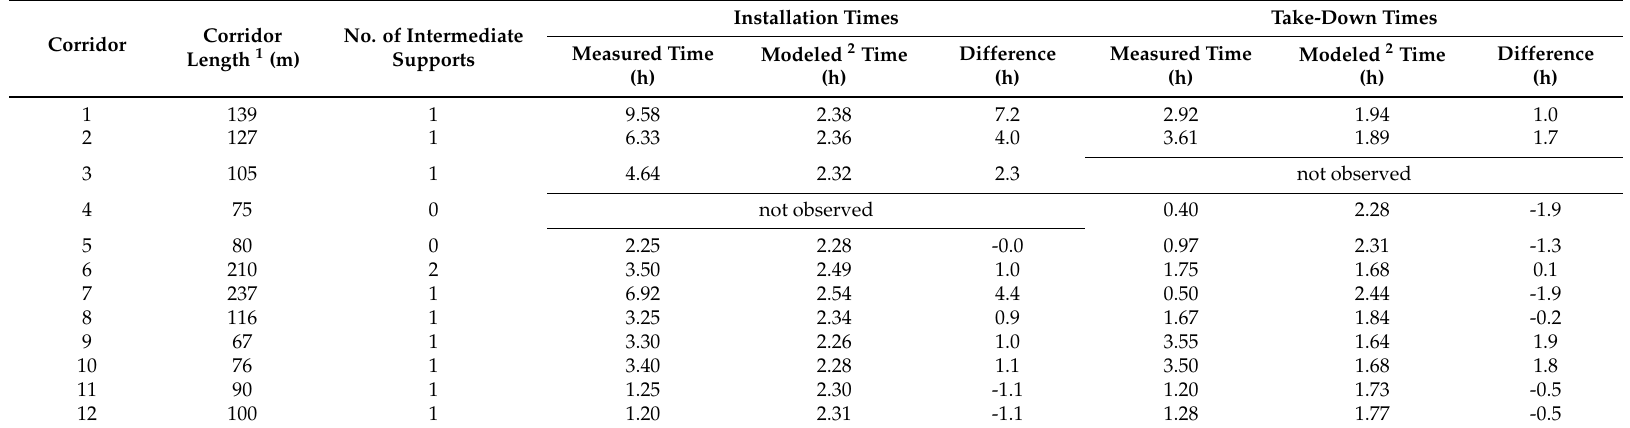
Table A3. Modeled and measured corridor installation times for the corridors studied during the field campaigns, the difference between the modeled and measured values as well as the associated corridor